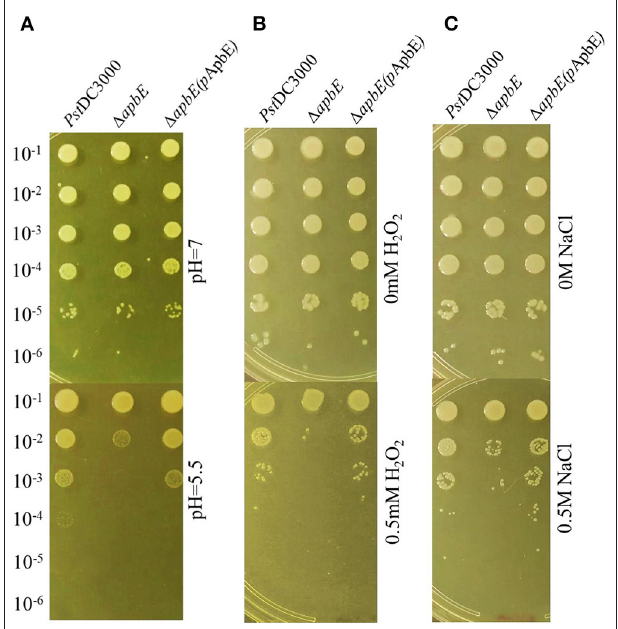
FIGURE 4 | ApbE plays an important role in stress responses in Pst DC3000. (A) Acid stress. (B) Oxidative stress. (C) Osmotic stress. Serial 10-fold dilutions were made from optical density at 600nm (OD 600 ) = 0.1 and 5 µ l for each dilution was added to plates containing acid, oxidative, and osmotic stresses, respectively. Photographs were taken 48h postincubation. Experiments were performed in triplicate and repeated three